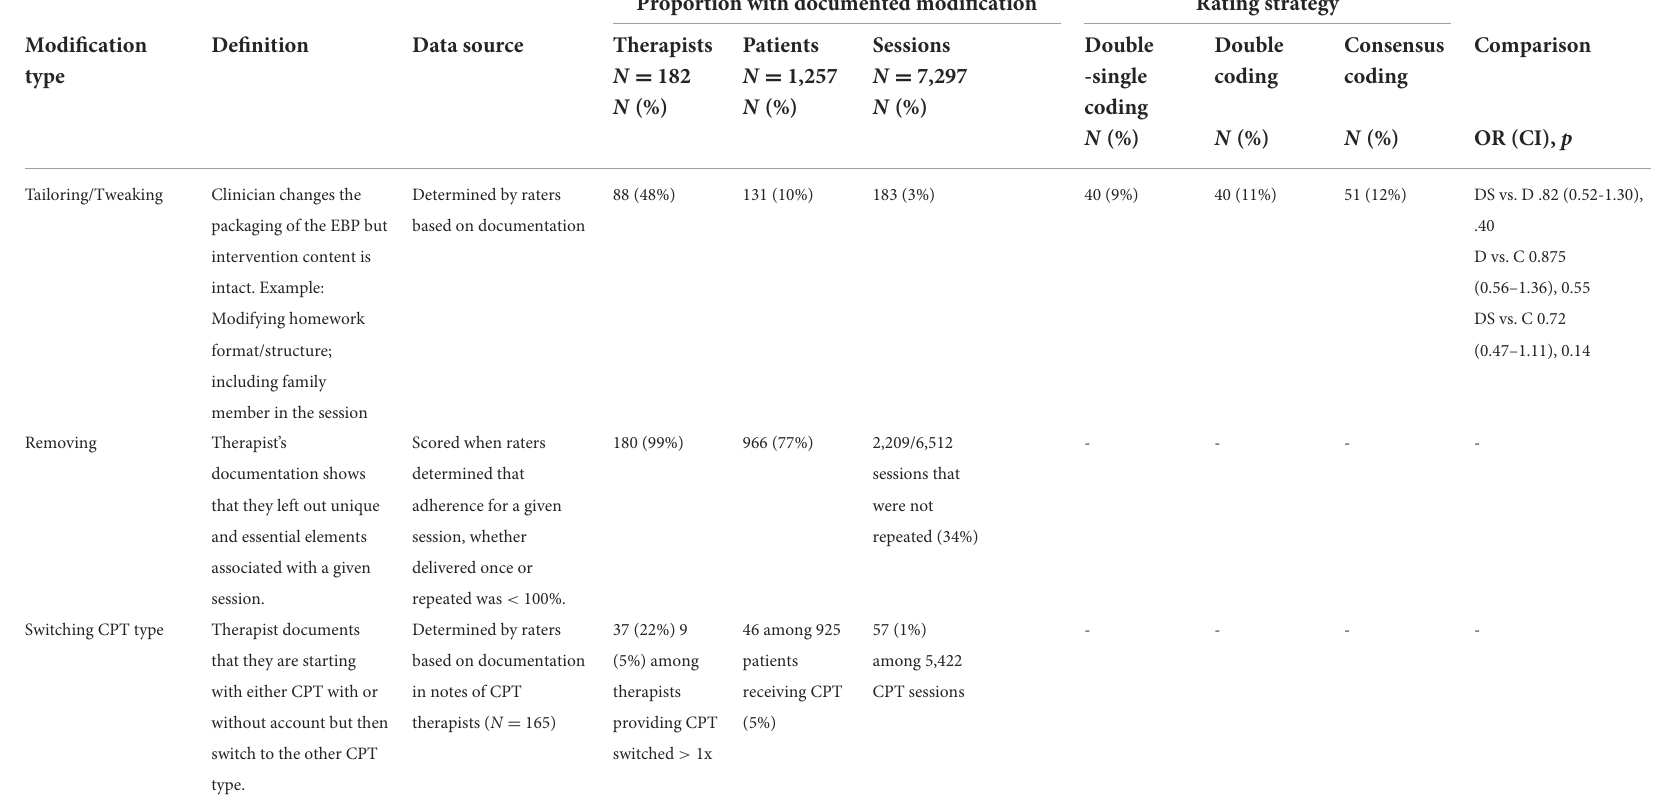
TABLE 1 Modifications identified in templated cognitive processing and prolonged exposure